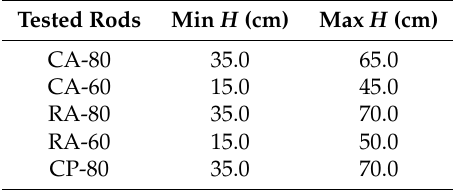
Table 3. Range of exposed length H of the rods in dry sand.